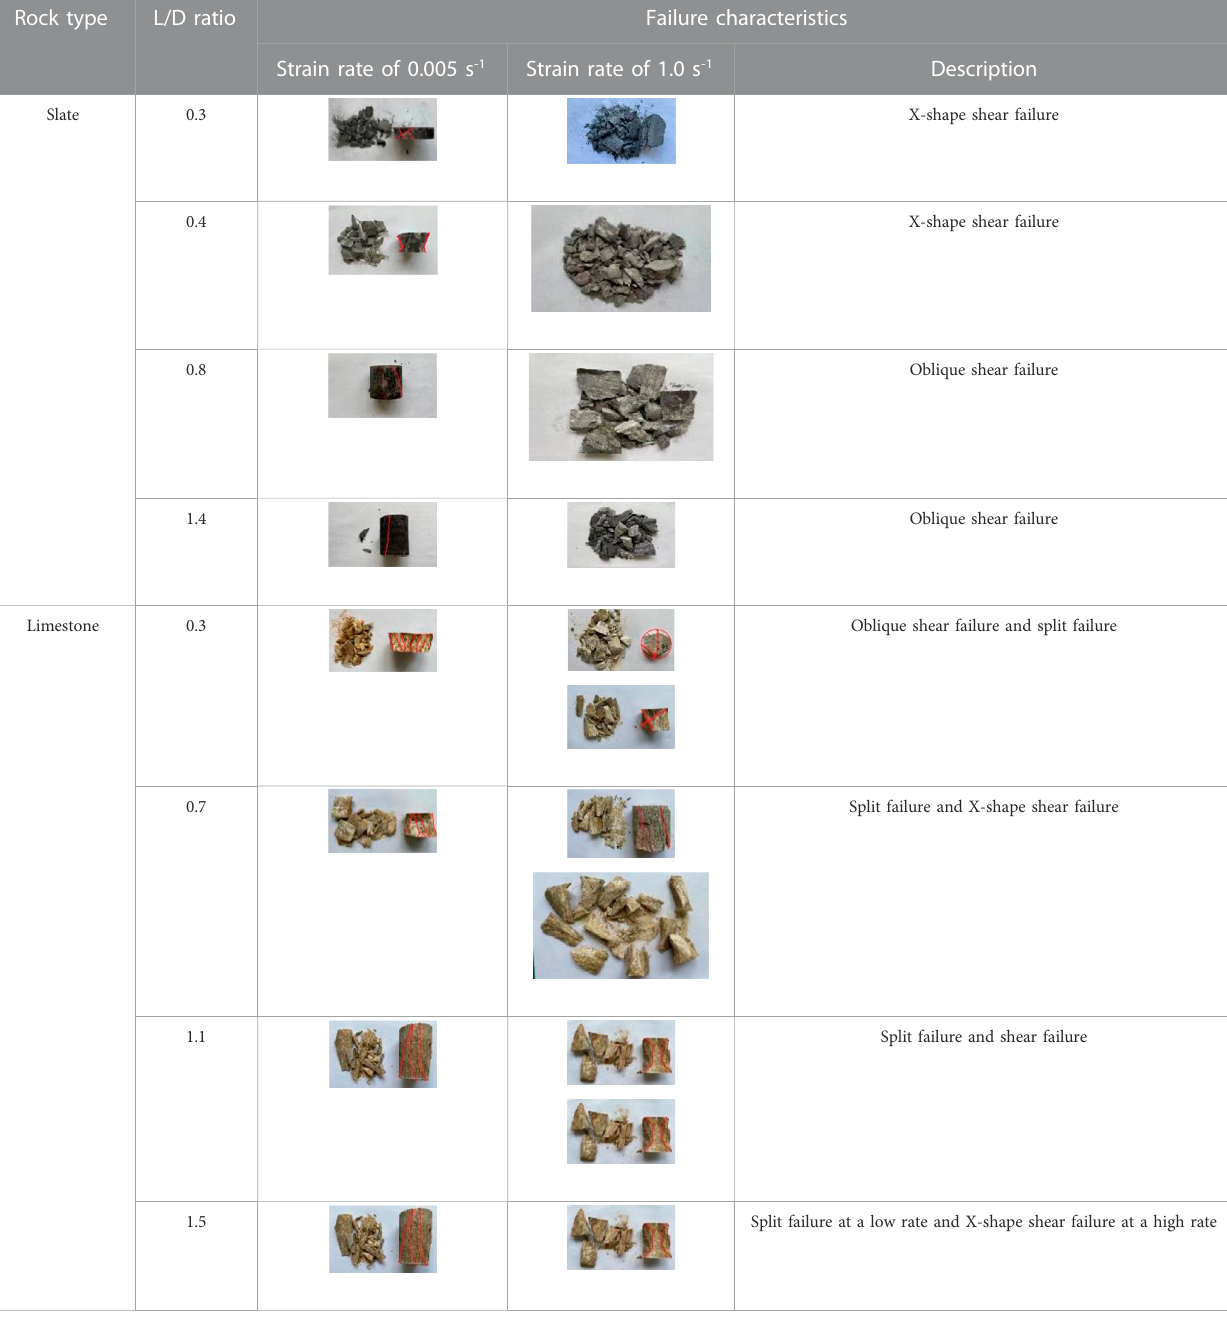
TABLE 3 Failure characteristics of slate and limestone with different L/D ratios under different strain